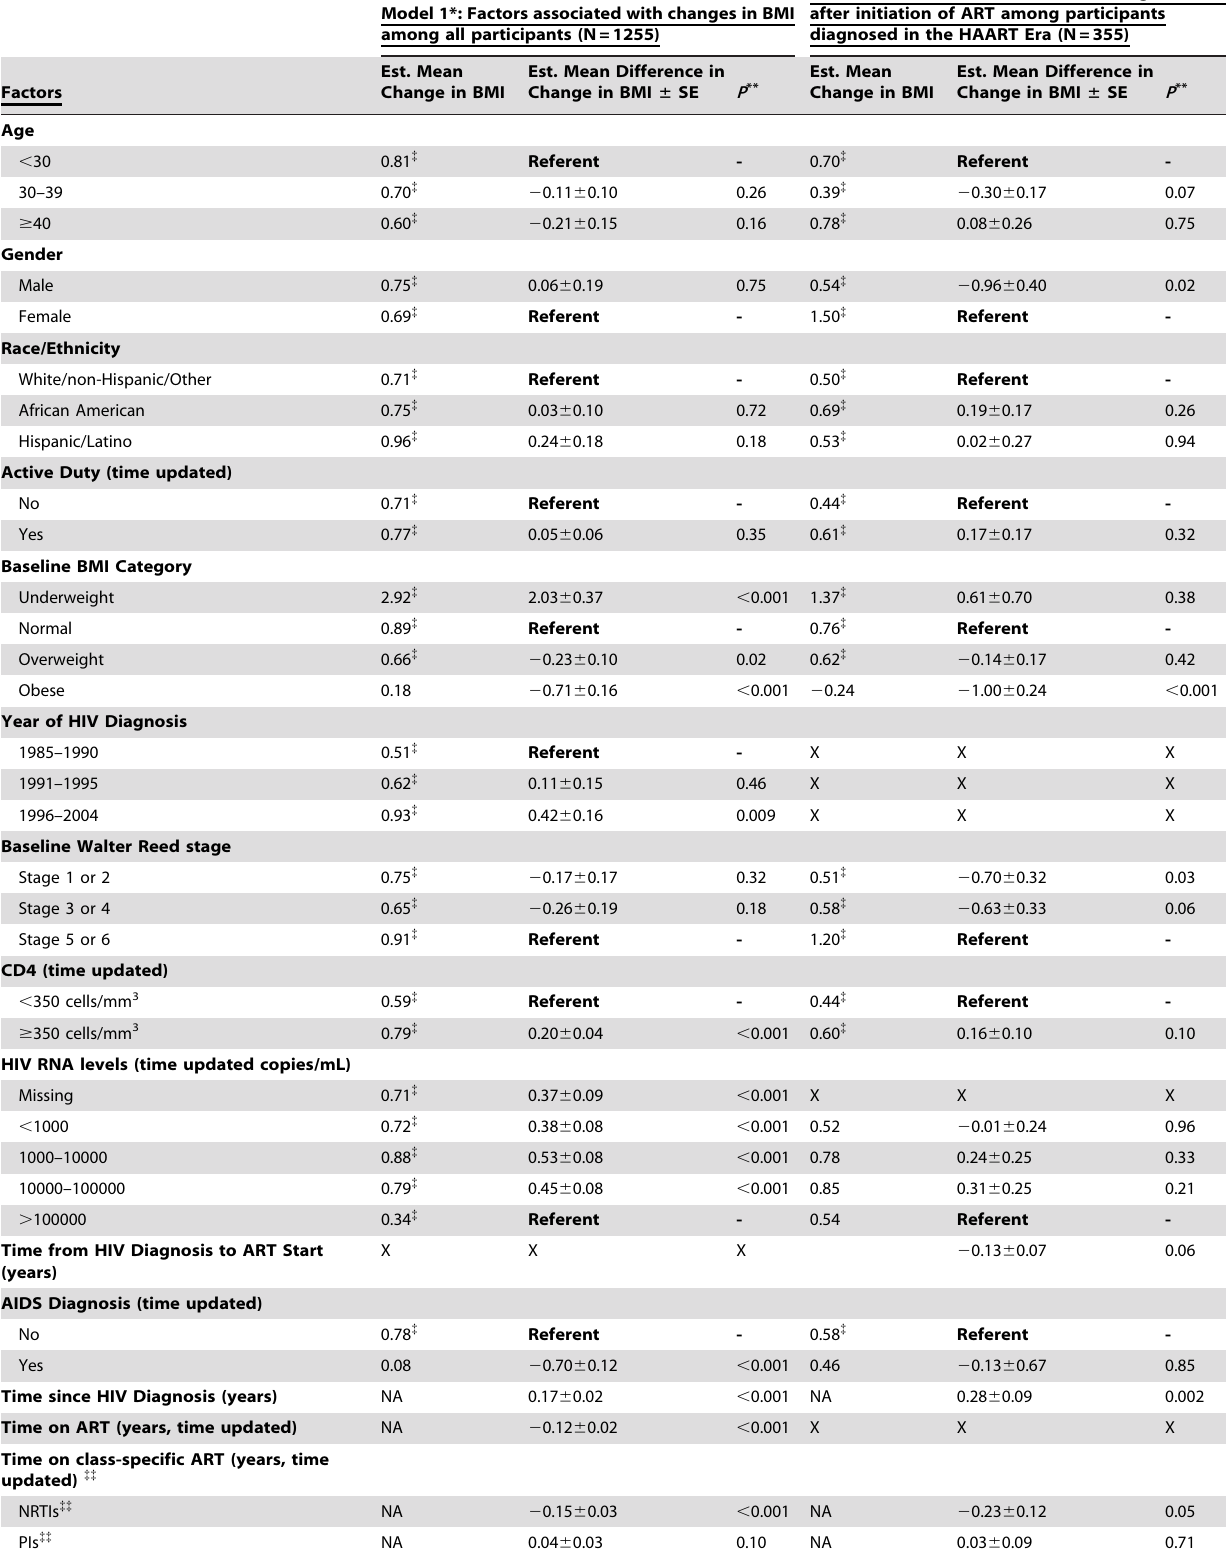
Model 2*: Factors associated with changes in BMI after initiation of ART among participants diagnosed in the HAART Era